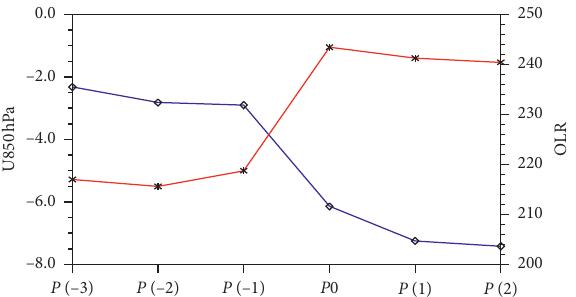
Figure 7: Pentad 850 hPa zonal wind (m/S) and OLR (W/m 2 ) averaged over the South China Sea (110 ° –120 ° E, 10 ° –20 ° N) from three pentads before the SCSSM withdrawal ( P − 3) to two pentads after the SCSSM withdrawal ( P + 2).